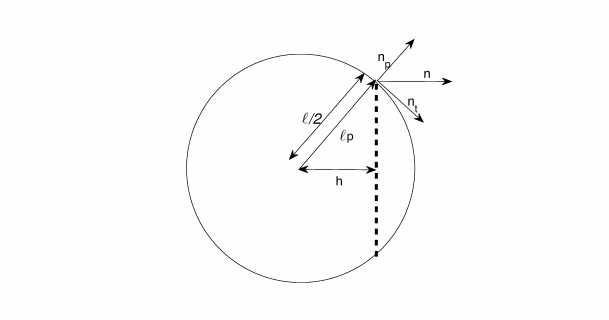
Figure 2. Contact condition. The fiber with orientation p is in contact with wall (dashed line). Wall normal n is decomposed in tangential and normal components to the sphere.